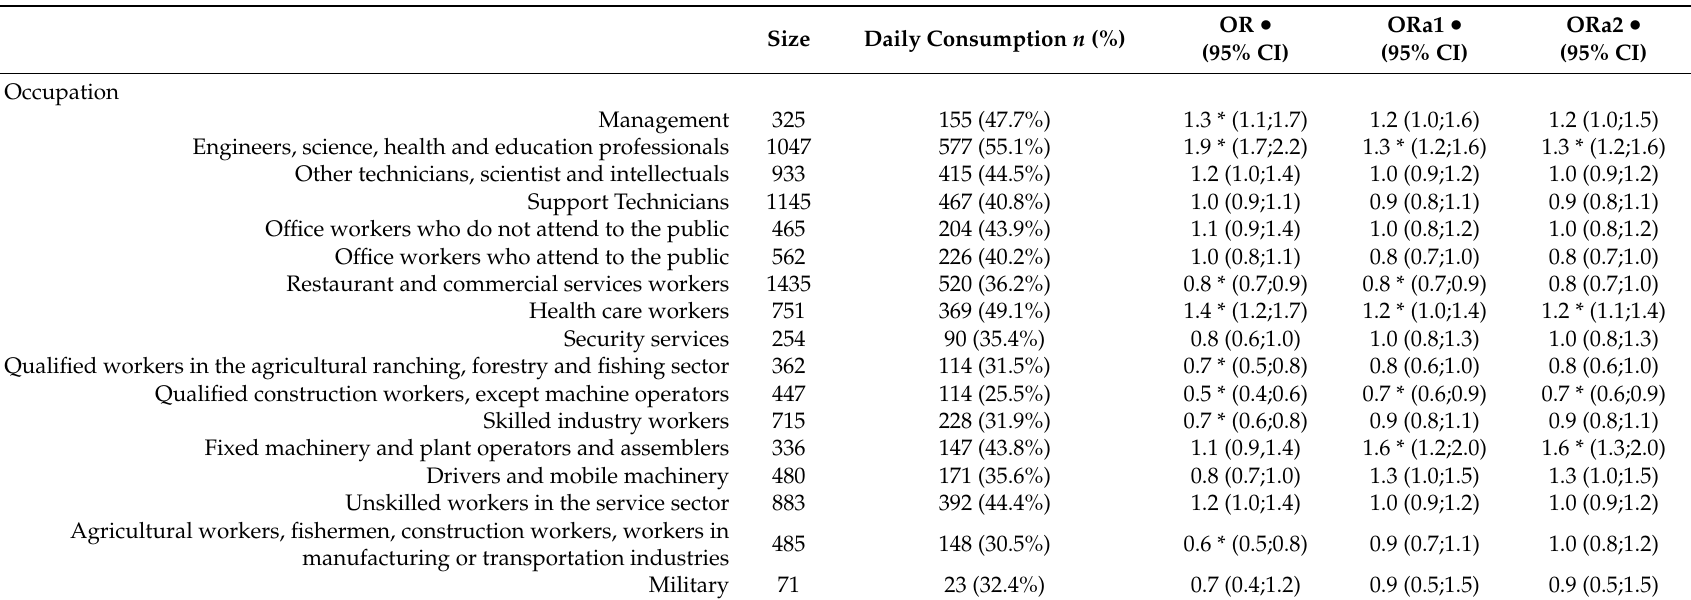
Table 4. Daily consumption of vegetables by